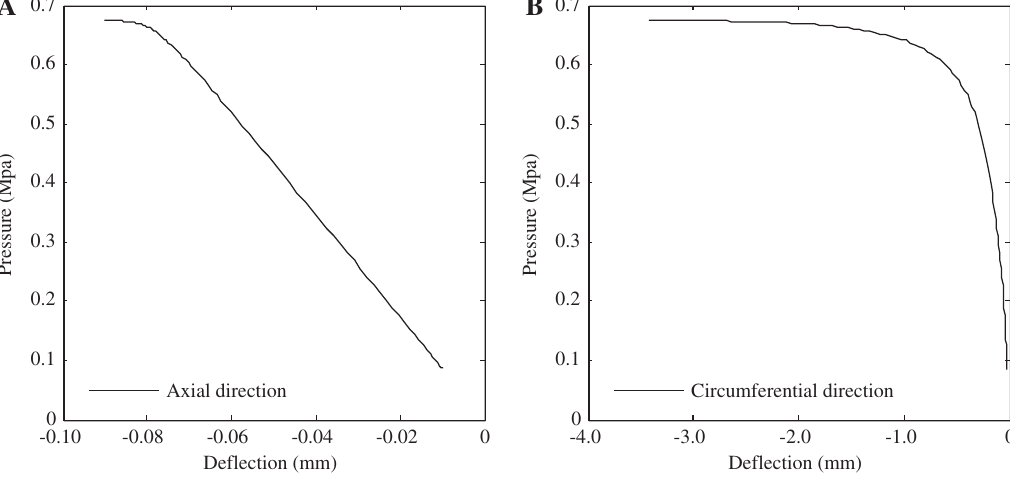
Figure 6: Typical pressure vs. deflection curves at point P (CTM3). (A) Axial direction. (B) Circumferential